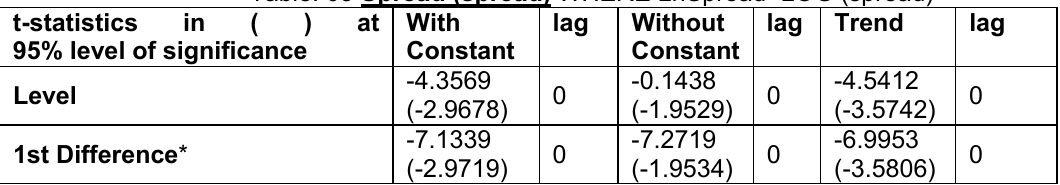
Table: 03 Spread (spread) WHERE LnSpread=LOG